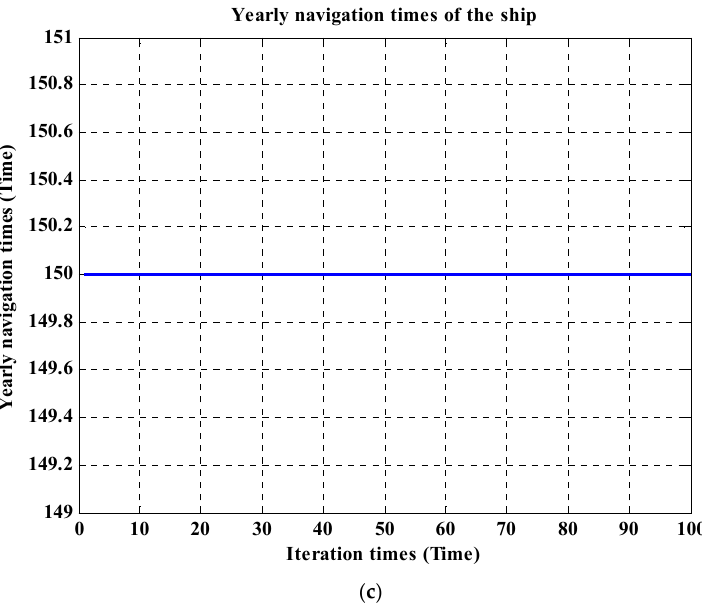
Figure 11. Simulation results of scenario 2 in case 2. ( a ) Variation of ship net income within the battery life over the optimization procedure ( b ) Battery capacity variation over the optimization procedure ( c ) variation of yearly navigations over the optimization procedure